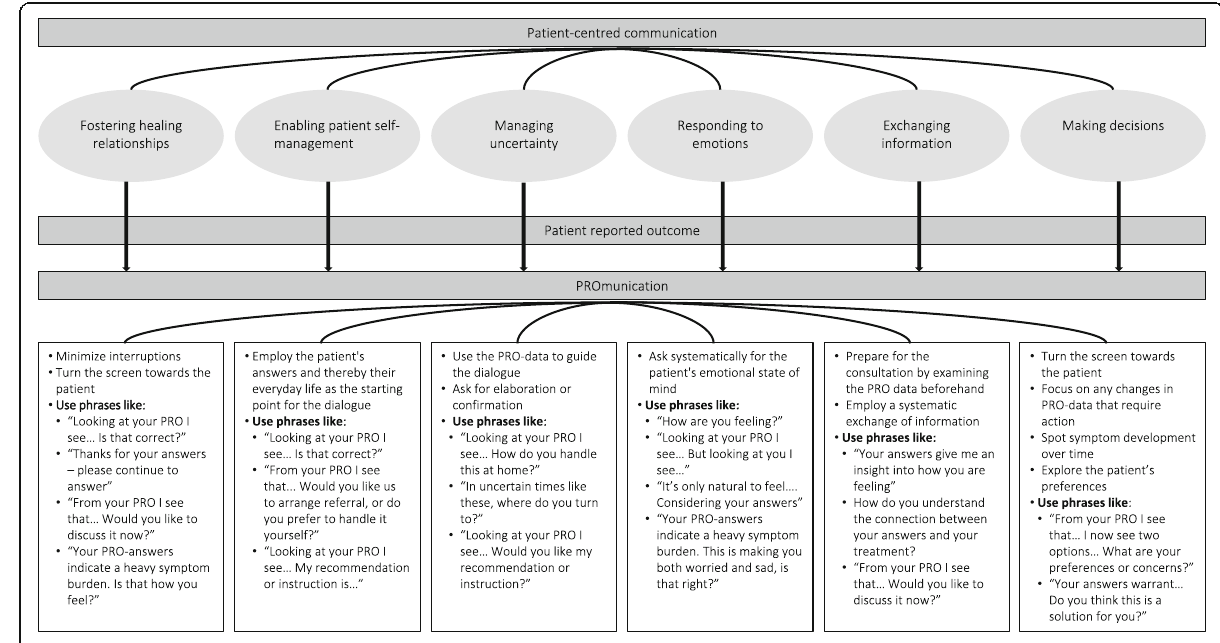
Fig. 3 PROmunication as a means of patient-centred communication through patient-reported